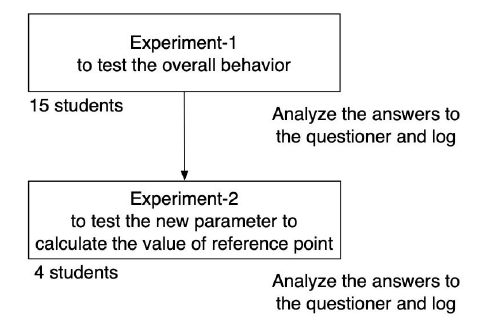
Figure 15. Outline of the